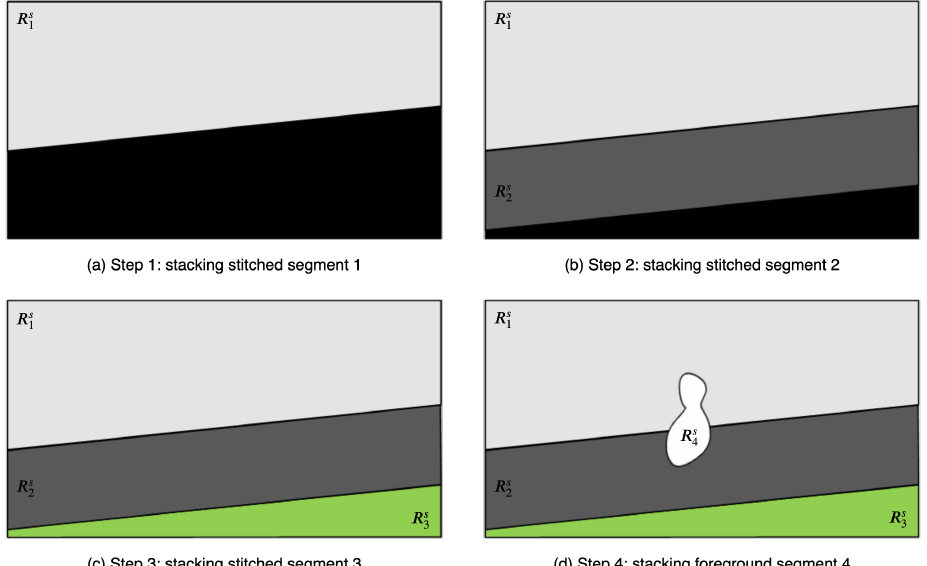
Figure 4. Panoramic frame